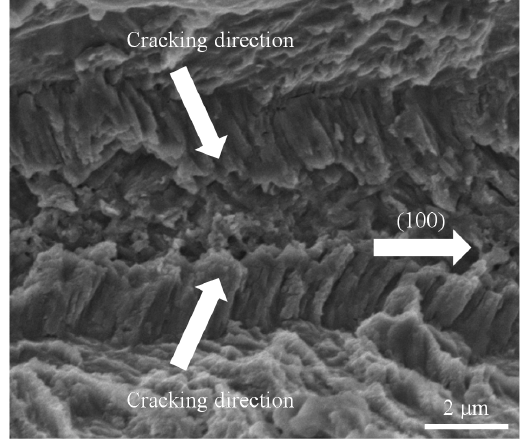
Figure 10. SEM image of the bottom of the laser-induced groove on HPHT showing cracks propagating in a diagonal direction.